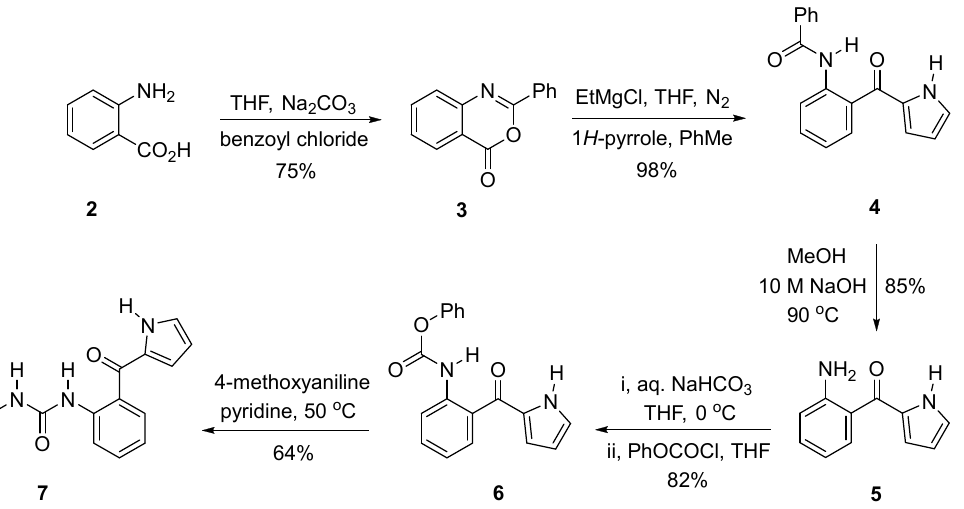
Scheme 1. Synthesis of 1-(2-(1 H -pyrrole-2-carbonyl)phenyl)-3-(4-methoxyphenyl)urea ( 7 ) from aminophenyl pyrrole ( 5 ) via carbamate ( 6 ).